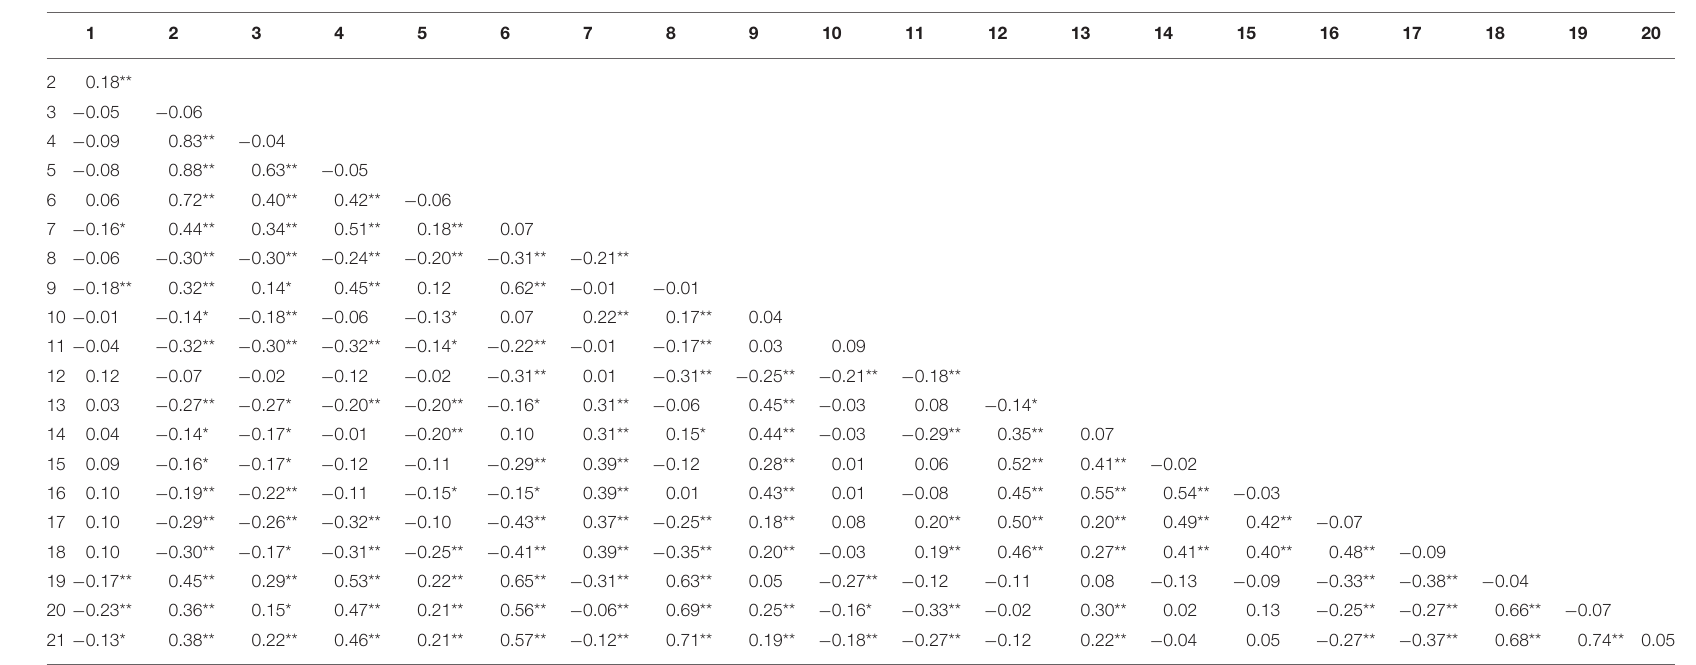
TABLE 3 | Correlations between